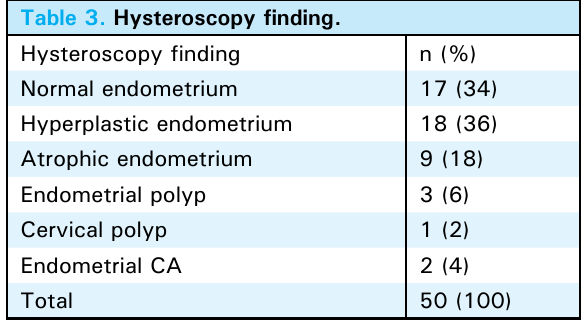
table 3. Hysteroscopy finding.